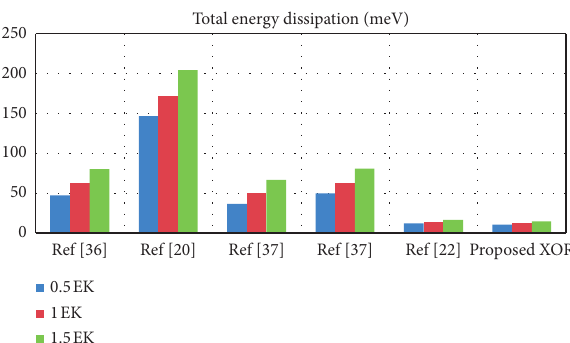
Figure 7: The total energy dissipation of the adders at three different tunneling energy